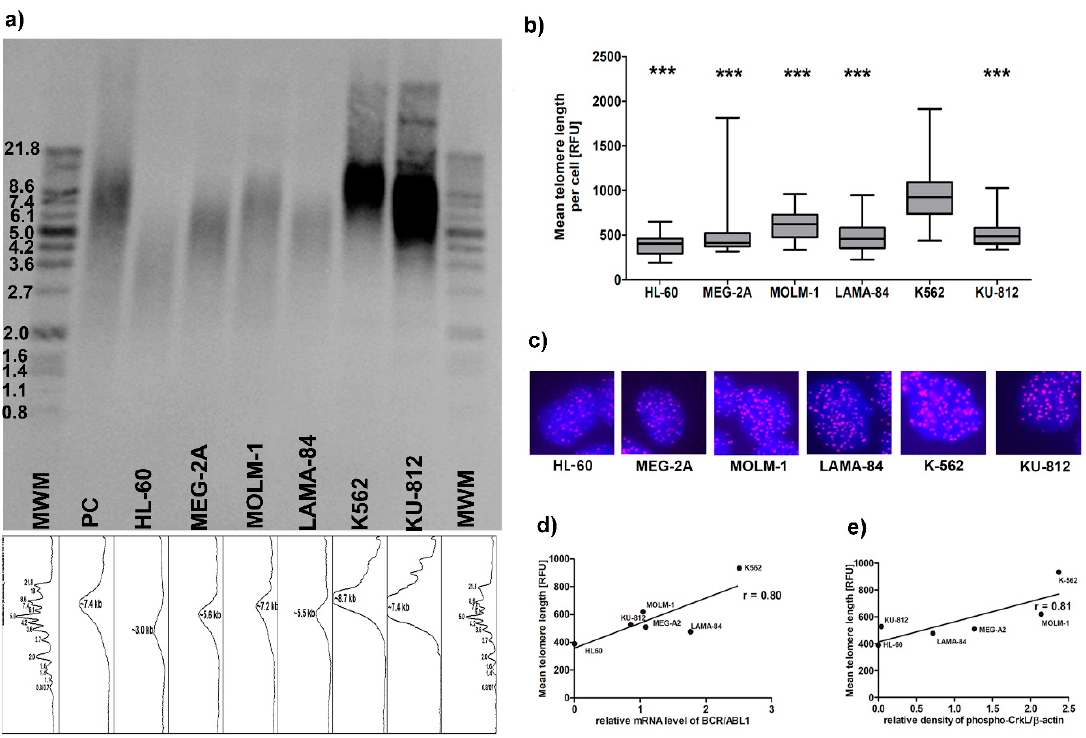
Figure 2. Telomere length dynamics in BCR/ABL1 -positive cell lines. Global picture of telomere length: ( a ) Southern blot analysis of telomere length, MWM- molecular weight marker, PC-positive control; Mean TRF length for each cell line was estimated on the base of the highest signal intensity peak from TRF due to multiple hybridization of telomeric-specific hybridization probe. Densitometric profile was performed to correspond to bands of DNA marker using ImageJ with gel analysis module. ( b ) telomere length in a single cell: fluorescence in situ hybridization (FISH) with PNA technique. The bars indicate SD, n = 100, *** p < 0.001 compared to the K562 (ANOVA and Tukey’s a posteriori test); ( c ) Representative images of PNA. Fluorescent signals were visualized under the Olympus BX61 with objective 40×; ( d , e ) Telomere length positively correlates with BCR/ABL1 expression and activity: ( d ) Pearson’s (r) correlations of mean telomere length and BCR/ABL1 expression and ( e ) activity of BCR/ABL1 kinase expressed as relative density of phospho-CRKL normalized to β -actin.